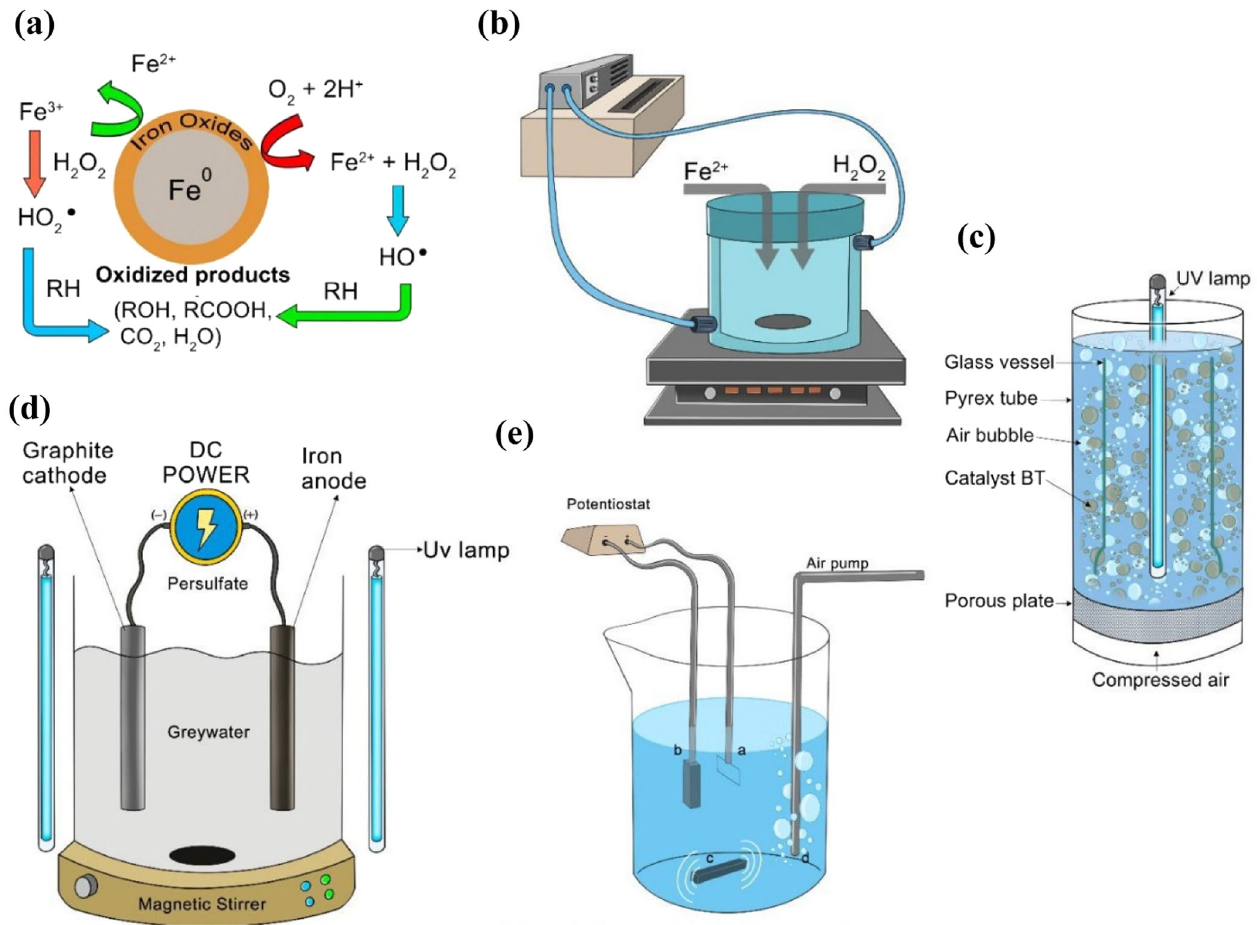
Fig. 2 Different Fenton processes. ( a ) Illustration of Fenton mechanism, ( b ) Fenton set-up, ( c ) Photo-Fenton set-up, ( d ) Photo-Electro-Fenton device, and ( e ) Electro-Fenton